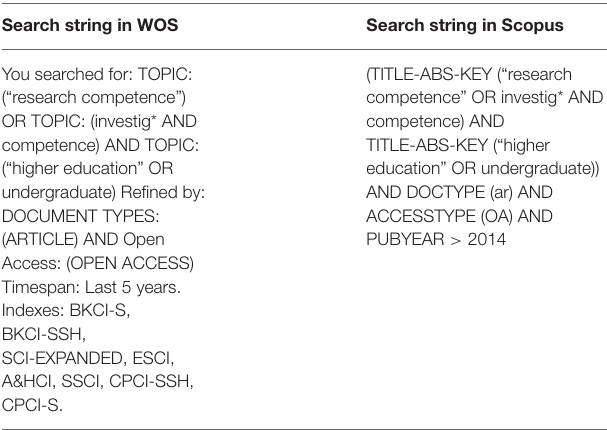
TABLE 2 | Search strings in Scopus and WOS.